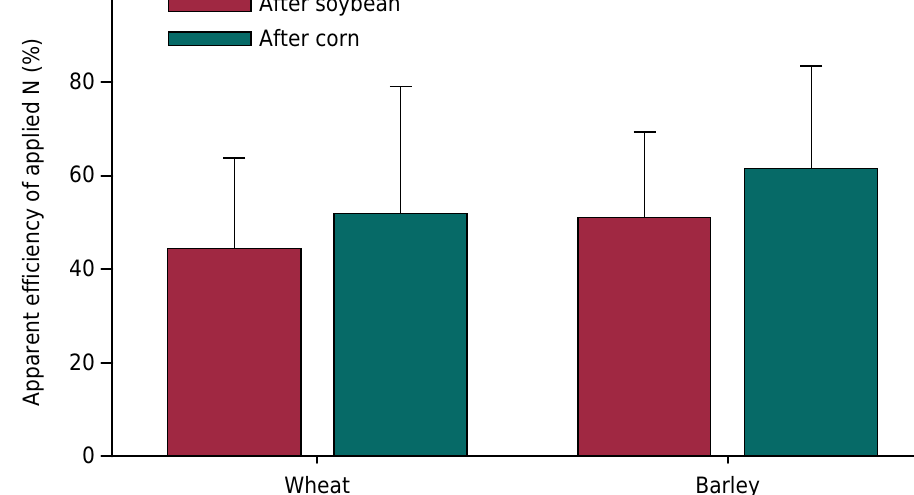
Wheat Figure 5. Apparent efficiency of urea-N applied as topdressing to wheat and barley grown after soybean and corn in the South-Central region of Paraná. Vertical bars indicate mean standard errors.